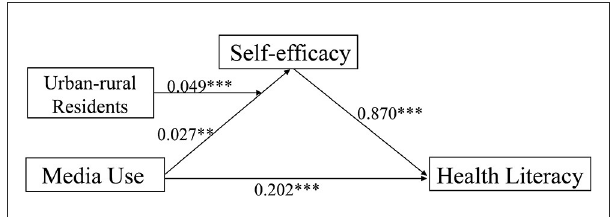
FIGURE3 Moderated mediation model. ** p < 0.01; *** p <